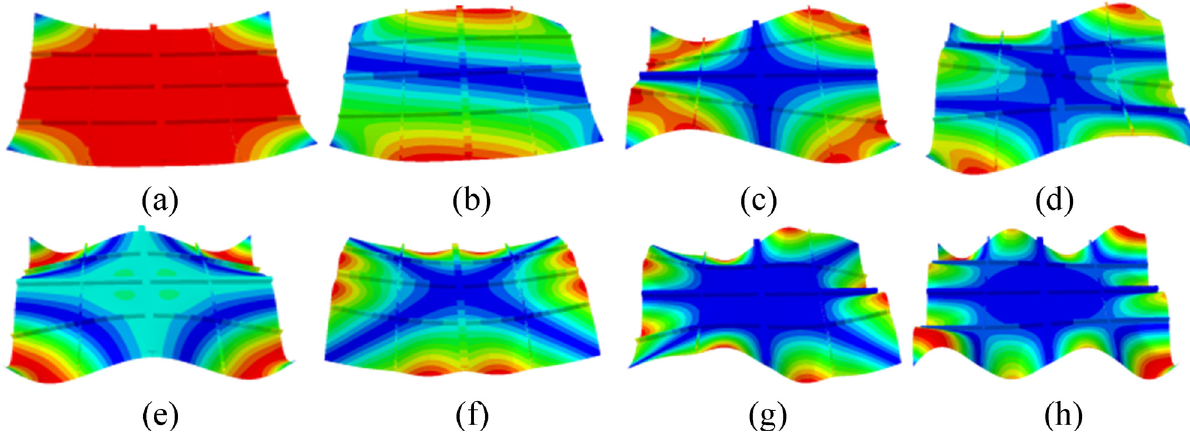
Figure 7: Structural mode simulation results: ( a ) 4.2 Hz, ( b ) 8.0 Hz, ( c ) 17.5 Hz, ( d ) , 43.5 Hz, ( e ) 47.7 Hz, ( f ) 51.9 Hz, ( g ) 73.3 Hz, and ( h ) 73.9 Hz.